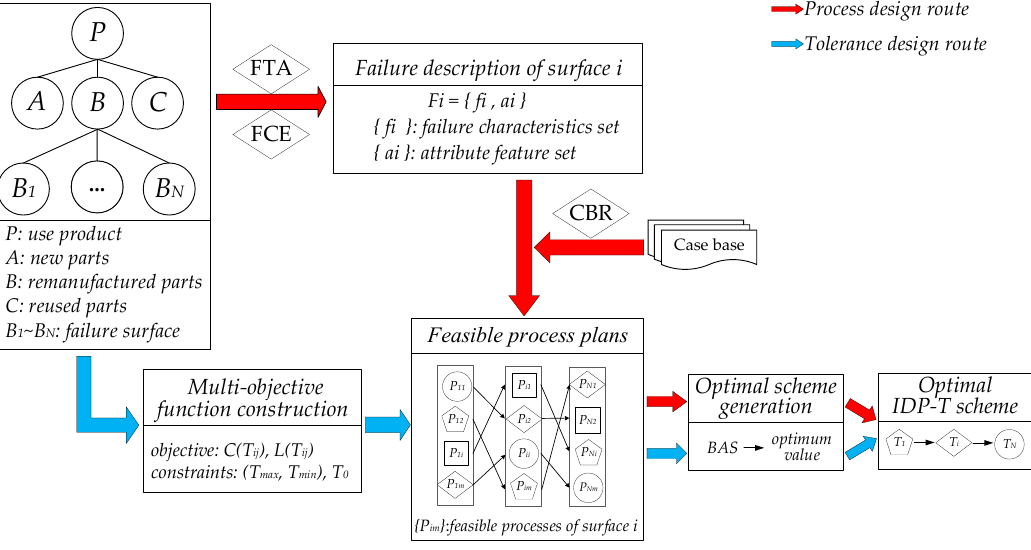
Figure 1. Framework of IDP-T for remanufacturing.